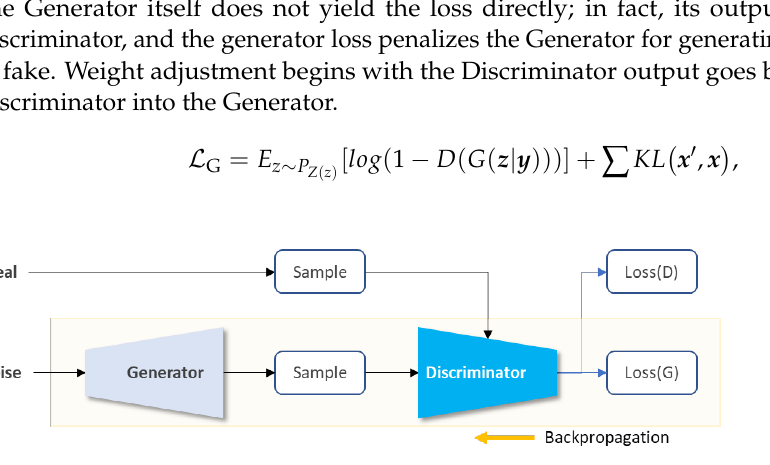
Figure 4. Generator training.